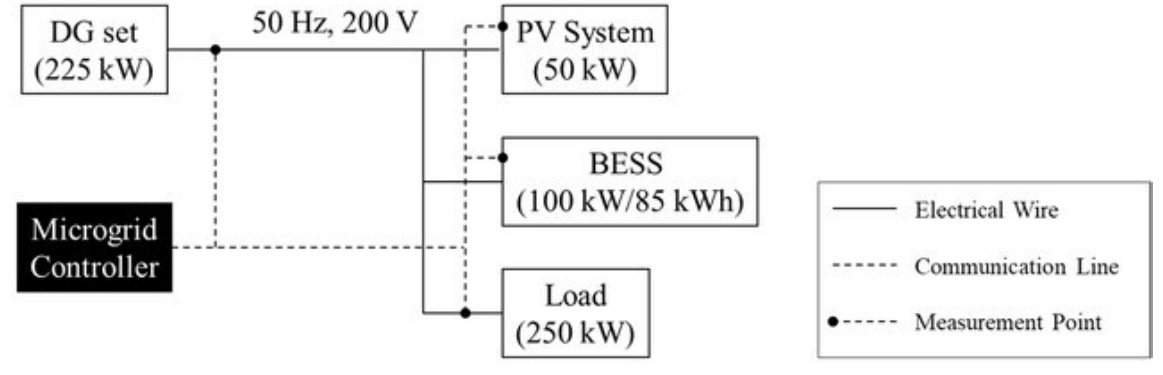
Figure 1. A typical Microgrid Topology.